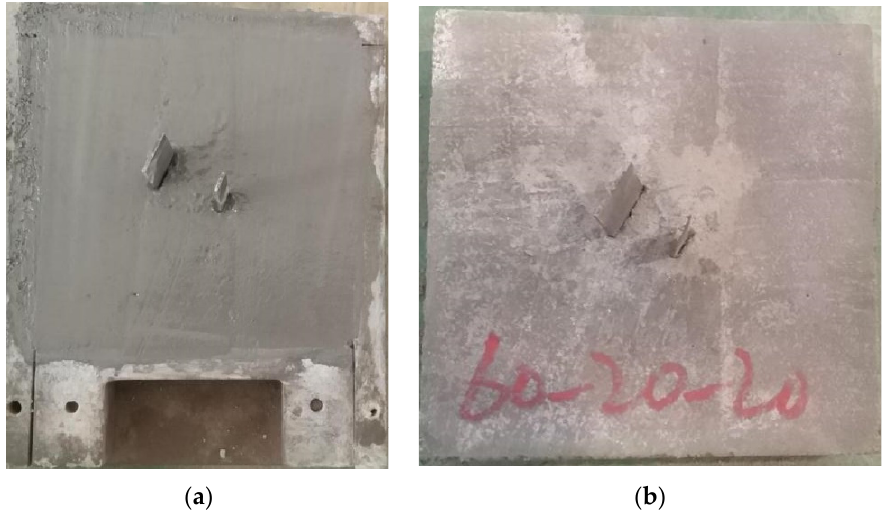
Figure 2. The preparation of rock-like specimens. ( a ) Mixture poured in the mold; ( b ) Dismantled